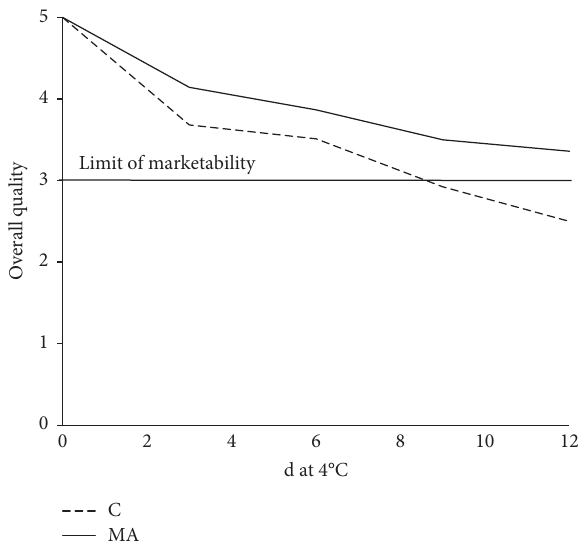
Figure 1: Influence of coating and time of storage on the overall visual quality of strawberry fruits (C: control fruits; MA: fruits coated with cactus mucilage+ ascorbic acid; scores: 5, excellent or having a fresh appearance; 3, average limit of marketability; 1,